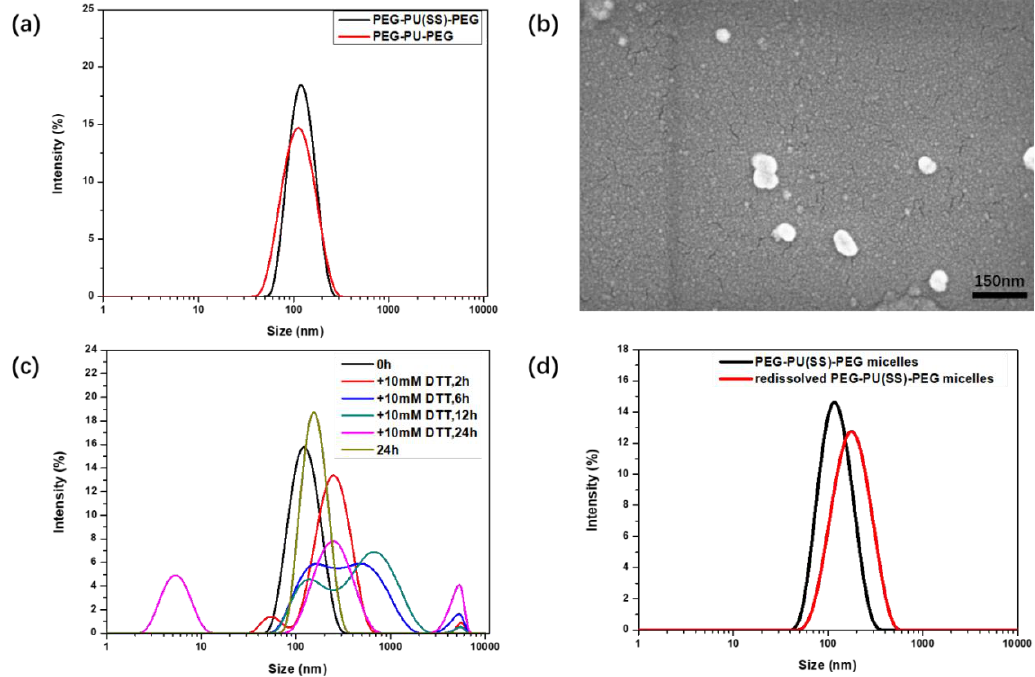
Table 2. Characterization of PEG-PU(SS)-PEG micelles and PEG-PU-PEG micelles.